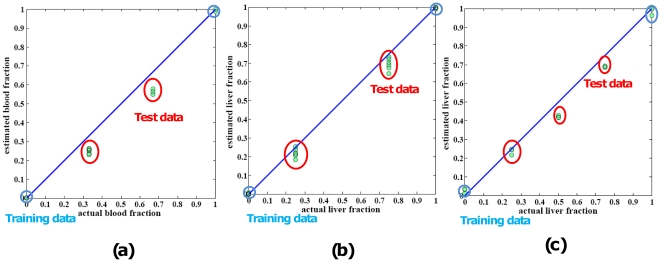
Statistical deconvolution of complex tissues yields accurate estimates of pure tissue fractions.Plotting of proportions of cell lines determined from deconvolution (y axis) vs. proportions of the cell lines actually mixed (x axis) shows strong congruity. (a) Proportions of blood cells determined by deconvolution are similar to proportions determined by actual blood fraction. Diagonal lines are y = x, shown for reference, highlighting the agreement between the two methods. The training data in blue circles are from pure reference samples. The test data are from mixed samples with various mixing proportions. (b) Proportions of liver fraction determined by deconvolution are similar to actual liver fraction. (c) Proportions of liver cell lines determined from deconvolution vs. proportions of the cell lines actually mixed are shown a high consistency in rat liver vs. brain dataset.